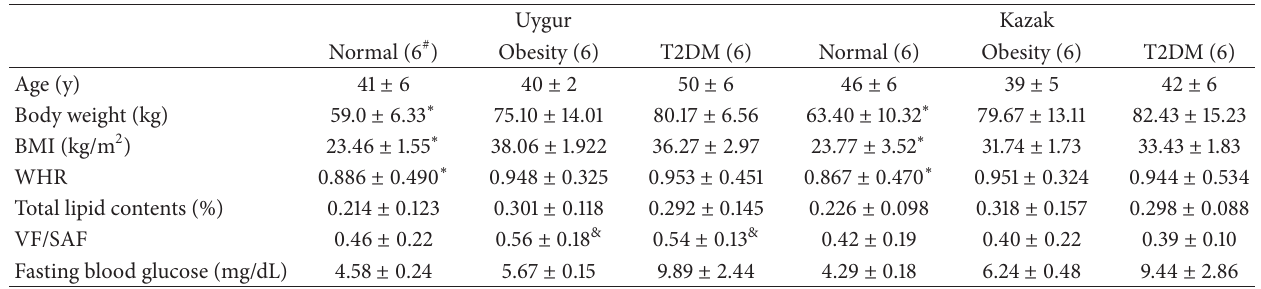
Table 3: Baseline characteristics of the